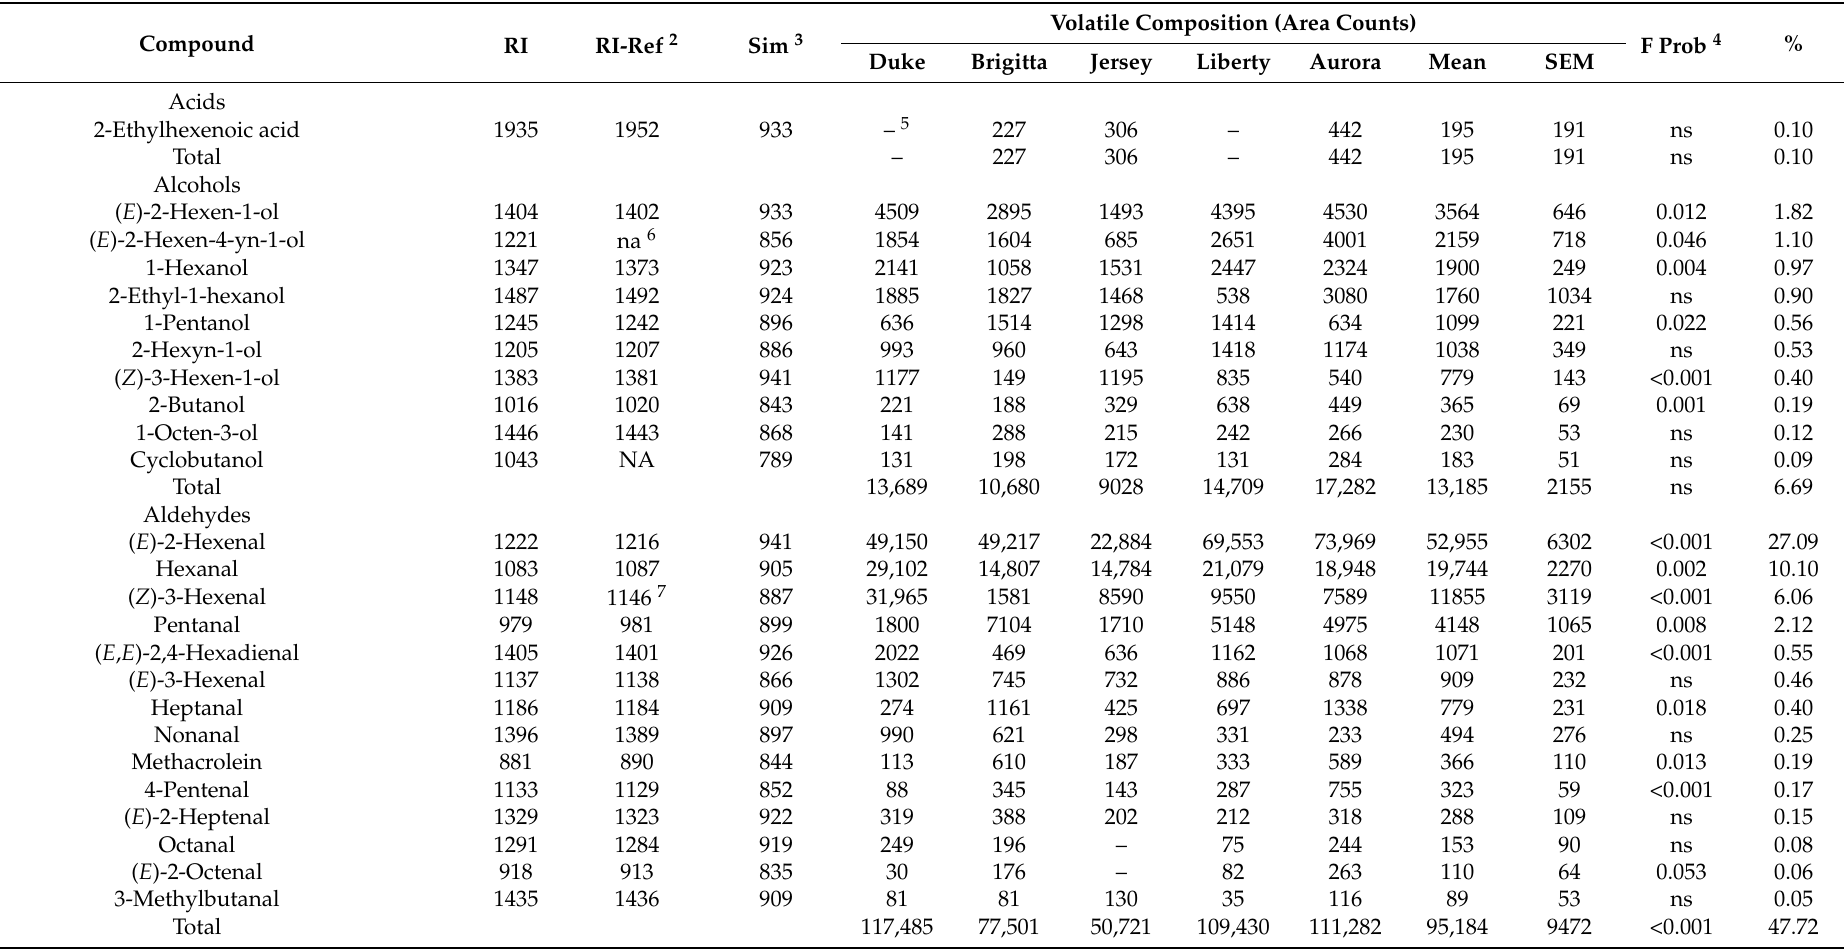
Table 4. Headspace volatile composition of cultivated highbush blueberry fruit of the cultivars ‘Duke’, ‘Brigitta’, ‘Jersey’, ‘Liberty’ and ‘Aurora’ determined by 2-dimensional gas chromatography–time of flight–mass spectrometry (GCxGC-TOF-MS) 1